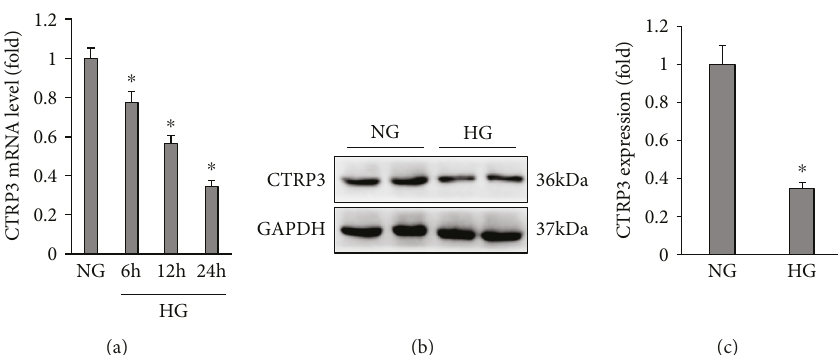
Figure 1: CTRP3 expression in HUVECs exposed to high glucose. (a) CTRP3 mRNA levels in HUVECs exposed to HG for indicated di ff erent times ( n = 5 ). (b) Protein levels of CTRP3 expressed in HUVECs exposed to HG for 24 hours ( n = 5 ). Data are expressed as mean ± SD of fi ve independent experiments. ∗ P < 0 05 when compared to the NG group.